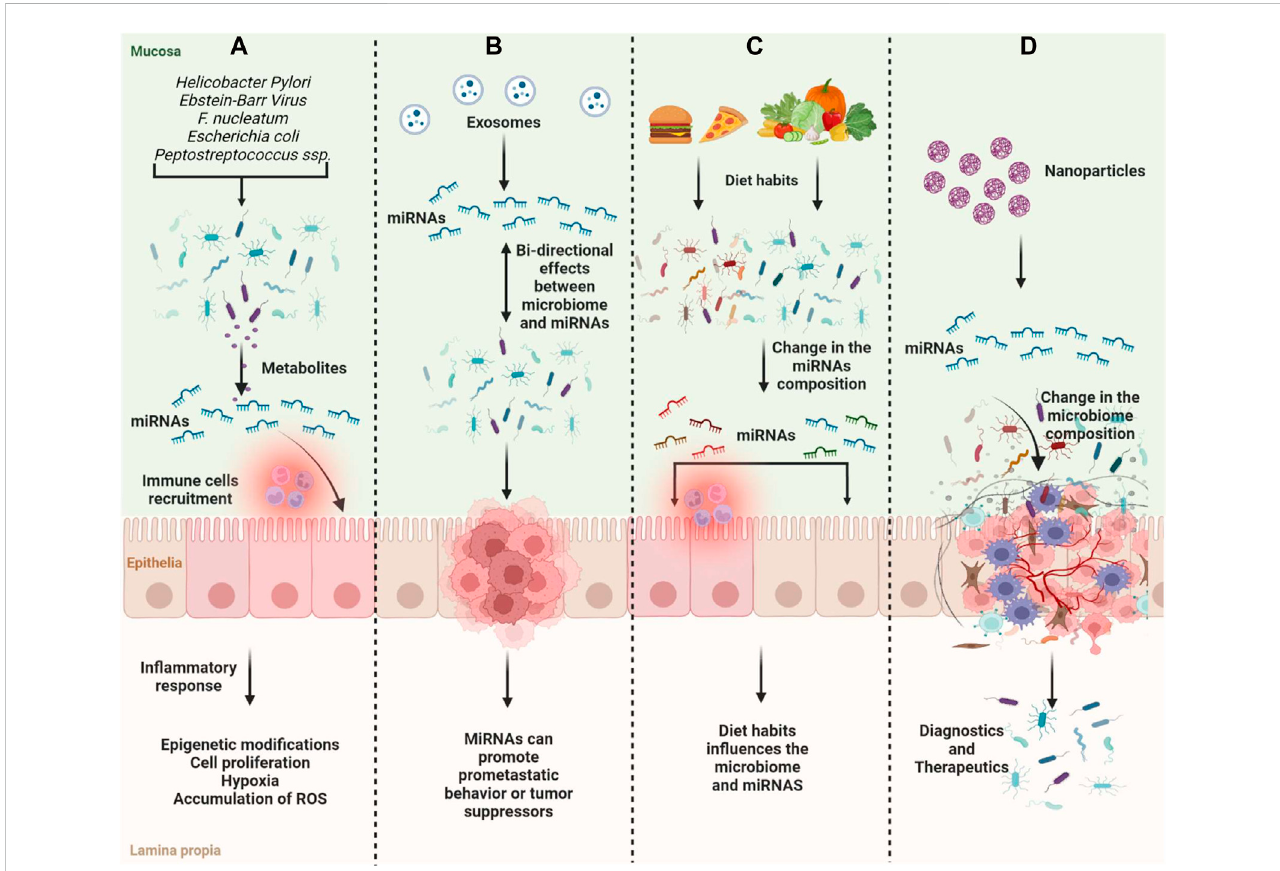
FIGURE 2 Scheme of the gut microbiome and miRNAs on tumor suppression and oncogenesis. (A) Microbiome compositions can induce changes in miRNA expressionandinducein fl ammation,immunerecruitment,andepigeneticmodi fi cationsassociatedwithcancerprogression; (B) MiRNAsandmicrobiotahave bi-directional effects on cancer development; (C) Diet habits can in fl uence the microbiome composition along with miRNA expression; (D) ncRNAs can be used as therapeutics in fl uencing the microbiome composition or as